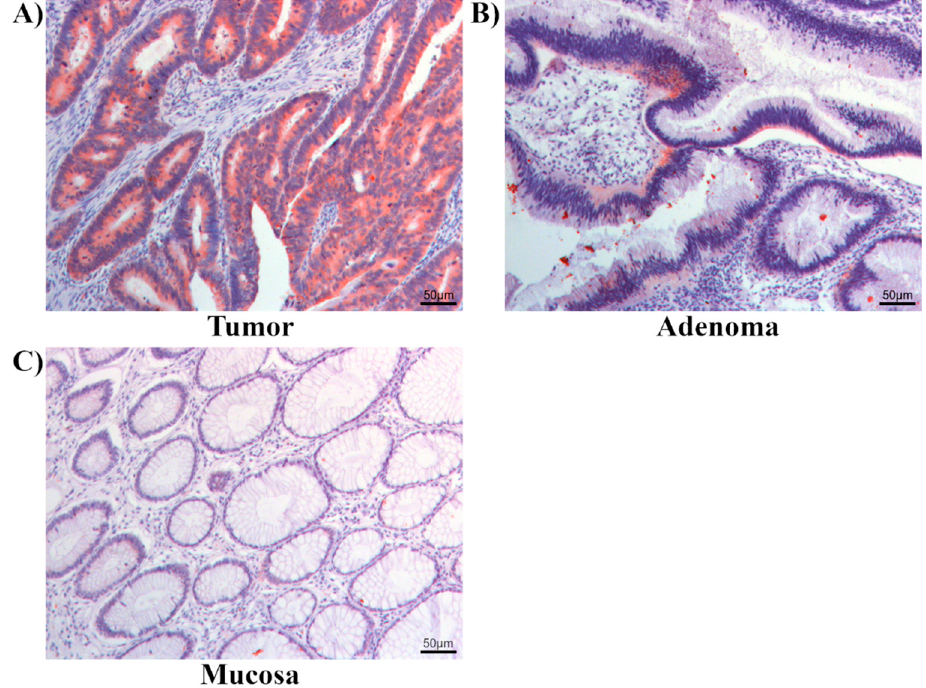
Figure 2. Immunohistochemistry revealing spatial localization of granulin protein. Granulin was strongly expressed in the tumor cells ( A ), particularly in the cytoplasm, and showed a descending expression in colorectal adenomas ( B ), whereas there was almost no expression of granulin in healthy mucosa cells ( C ).